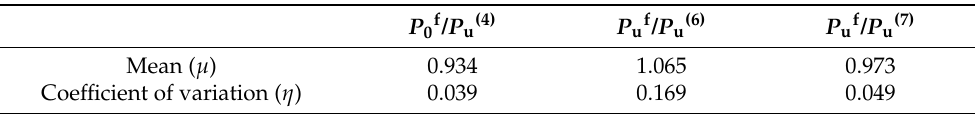
Table 4. Comparison of the shear load and ultimate shear capacities captured by the FE analysis with design